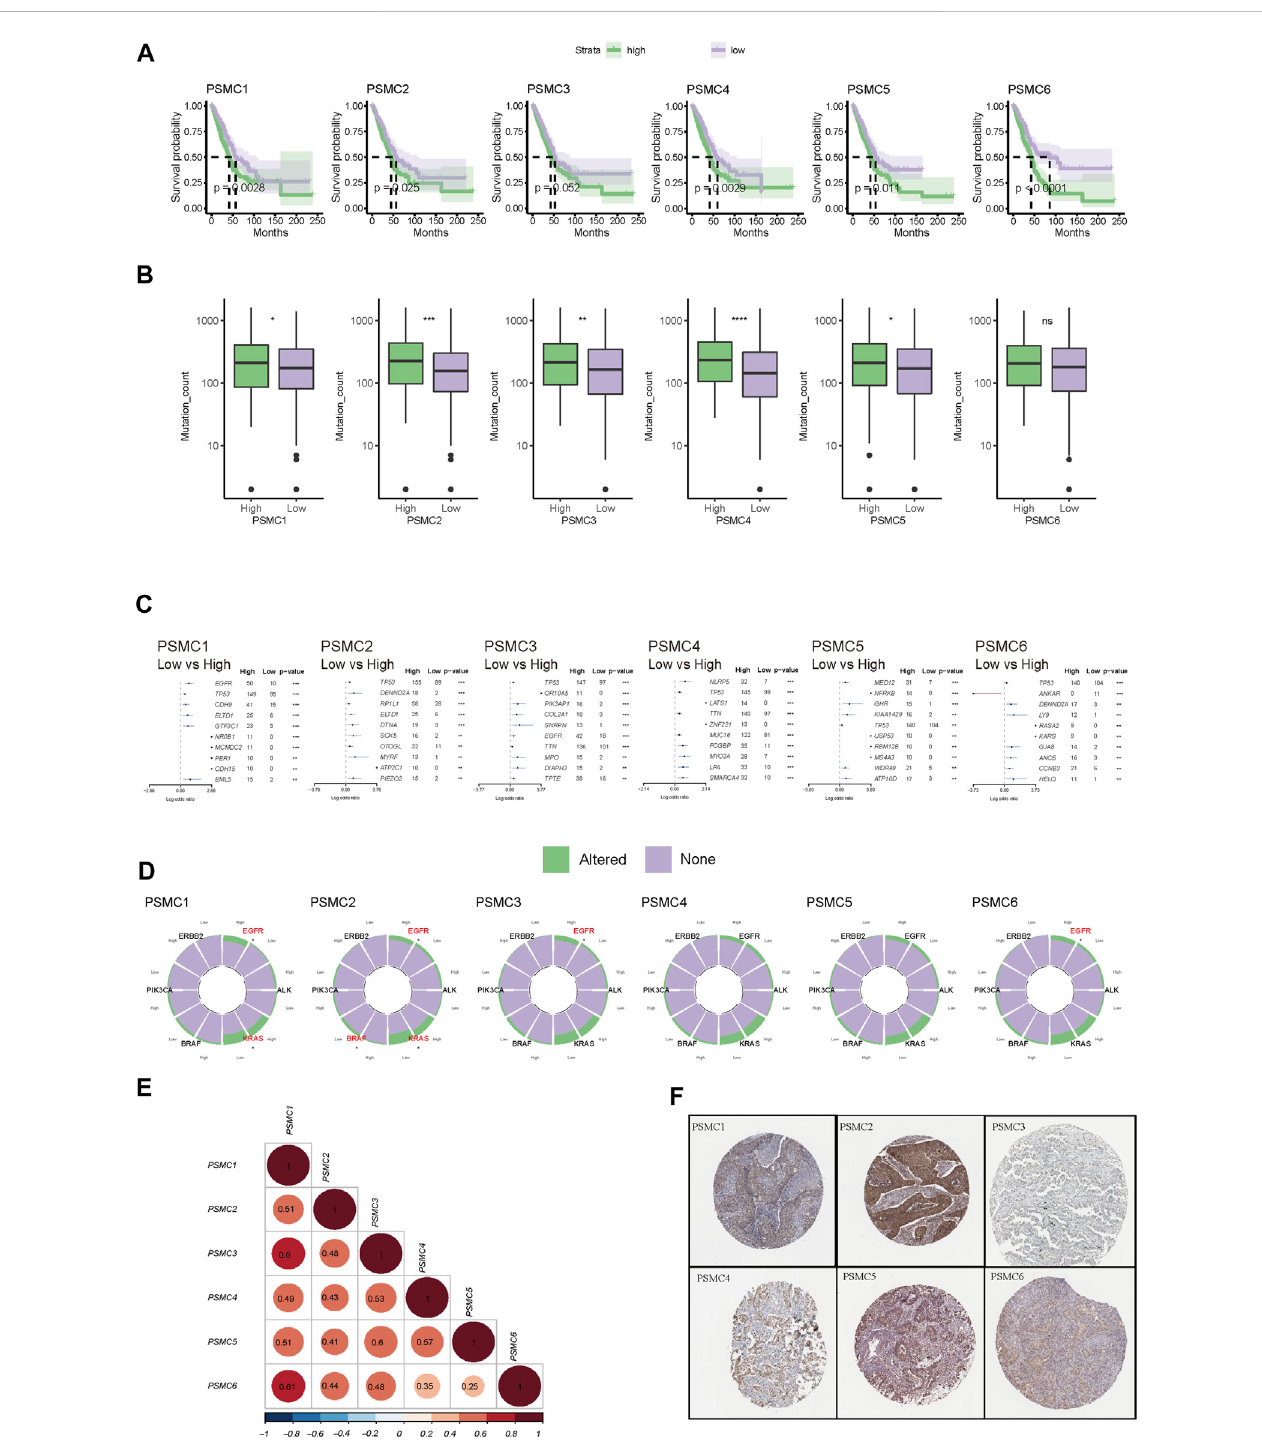
FIGURE 2 Correlation between PSMC gene expression and the prognostic and genomic features in lung adenocarcinoma (LUAD). (A) Kaplan – Meier curves strati fi ed by the expression level of each PSMC gene family member. Patients were classi fi ed into high- or low-expression groups based on the median expression cutoff value of each PSMC gene. (B) Differences in the mutation counts between the high- and low-expression groups of each PSMC gene. (C) Genomicdifferencebetweenthehigh-andlow-expressiongroupsofeachPSMCgene.Thosegeneswithlog(oddsratio)over0weremoreprevalentat the high-expression level. (D) Differences in the genomic alterations of driver genes, including EGFR, ALK (translocation), KRAS, BRAF, PIK3CA, and ERBB2. Also, those genes labeled with the red color had a signi fi cant difference in prevalence between high and low expression levels. (E) Expression correlation between each PSMC gene. (F) Protein expression of each PSMC gene in LUAD revealed by immunochemistry in the Human Protein Atlas. * p < .05, ** p < .01, *** p < .001, and **** p <